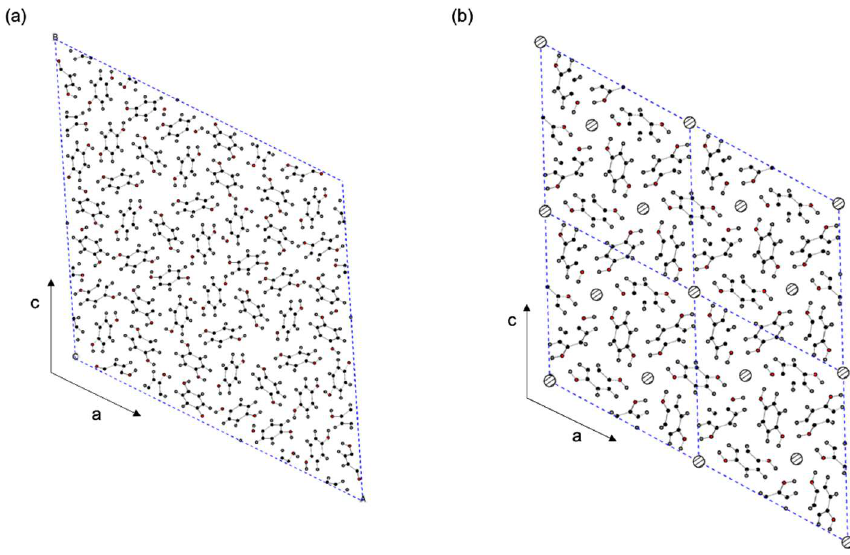
Figure 2. Crystal structures of ( a ) α-form of pure HQ and ( b ) the β-form of HQ clathrate. Two axes indicate the direction of the lattice parameters of a and c.